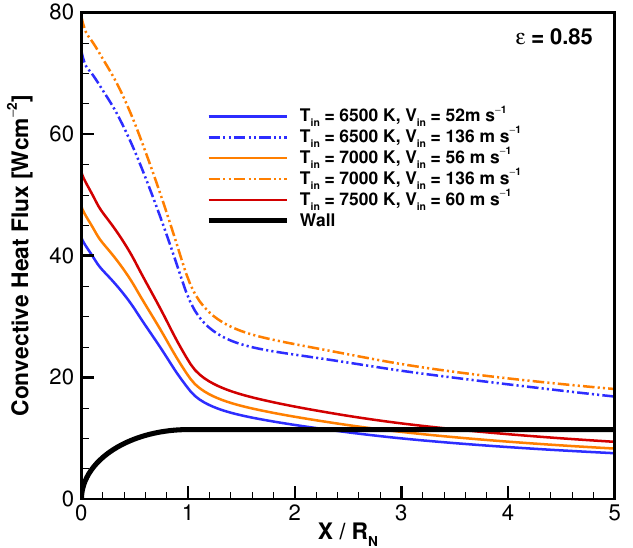
Figure 10. Convective heat flux at various torch conditions. All for a wall with an emissivity of 0.85. Heat flux measurements were taken in the ICP torch facility using a 12.5 mm radius slug calorimeter with values ranging from 24 W cm − 2 at 2.0 A to 42 W cm − 2 at 2.5 A. Since the sample has a radius of 9 mm, one could expect an 18% increase in the maximum heat flux to the sample. This adjusts the range from 28 W cm − 2 at 2.0 A to 50 W cm − 2 at 2.5 A. This suggests the slower inlet (case 3) provides a better estimate of the torch conditions. However, it is important to recall that the slug calorimeter has a fundamentally different distribution of heat flux across its body, having a peak heat flux that occurs on the probe’s shoulder, as opposed to the stagnation point along the centerline. Thus, direct scaling based on nose radius is not feasible. Regardless, the simulated results reproduce the proper trends as seen in the experiments when varying the torch temperature under fixed chamber